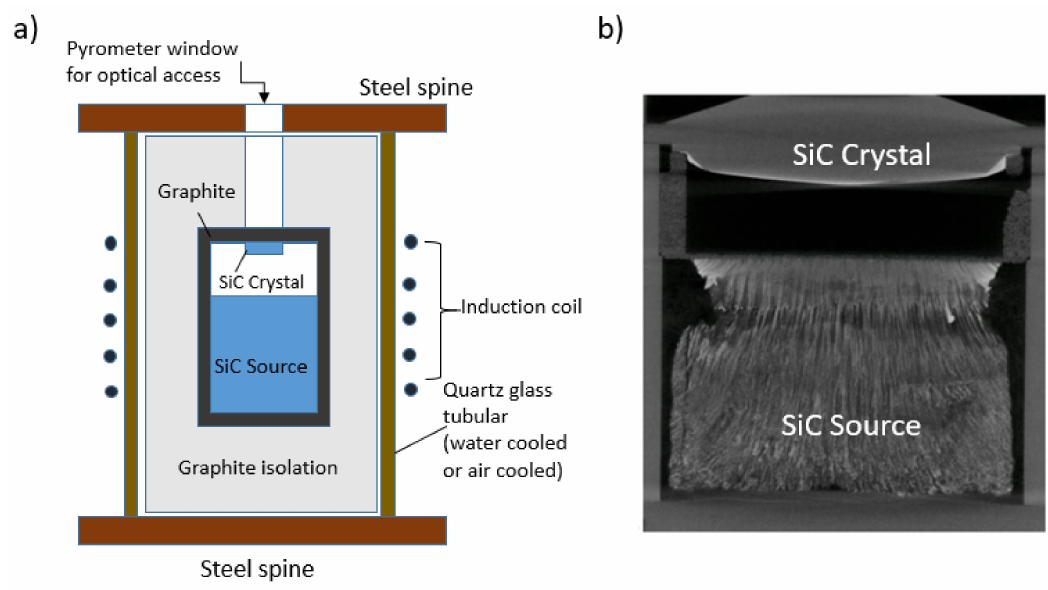
Figure 6. ( a ) A sketch of the PVT growth method for SiC boules and ( b ) 2D visualization of the PVT growth to image the great details about the morphology and the crystal growth interface and conditions